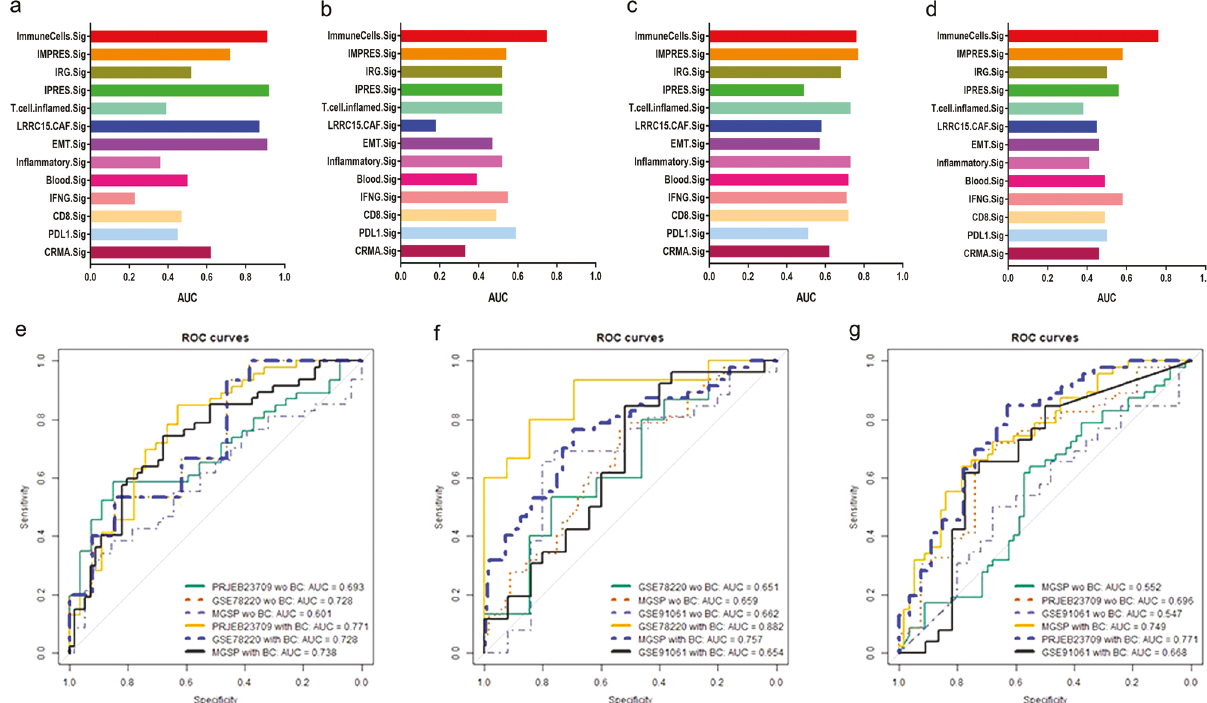
Fig. 2 Comparison of the performance of ImmuneCells.Sig with other ICT (immune checkpoint therapy) response signatures and independent validation of ImmuneCells.Sig without or with batch effect correction. The multiple bar plots of the fi vefold cross-validation calculated mean testing AUC (Area Under The Curve) values of the whole 13 ICT signatures are shown in a For the GSE78220 data set. b For the GSE91061 data set. c For the PRJEB23709 data set. d For the MGSP data set. e Testing the predictivity of the ImmuneCells.Sig trained in the GSE91061 data set in the other three independent data sets — PRJEB23709, GSE78220, and MGSP without or with batch effect correction. f Testing the predictivity of the ImmuneCells.Sig trained in the PRJEB23709 data set in the other three independent data sets — GSE78220, MGSP, and GSE91061 without or with batch effect correction. g Testing the predictivity of the ImmuneCells.Sig trained in the GSE78220 data set in the other three independent data sets — MGSP, PRJEB23709, and GSE91061 without or with batch effect